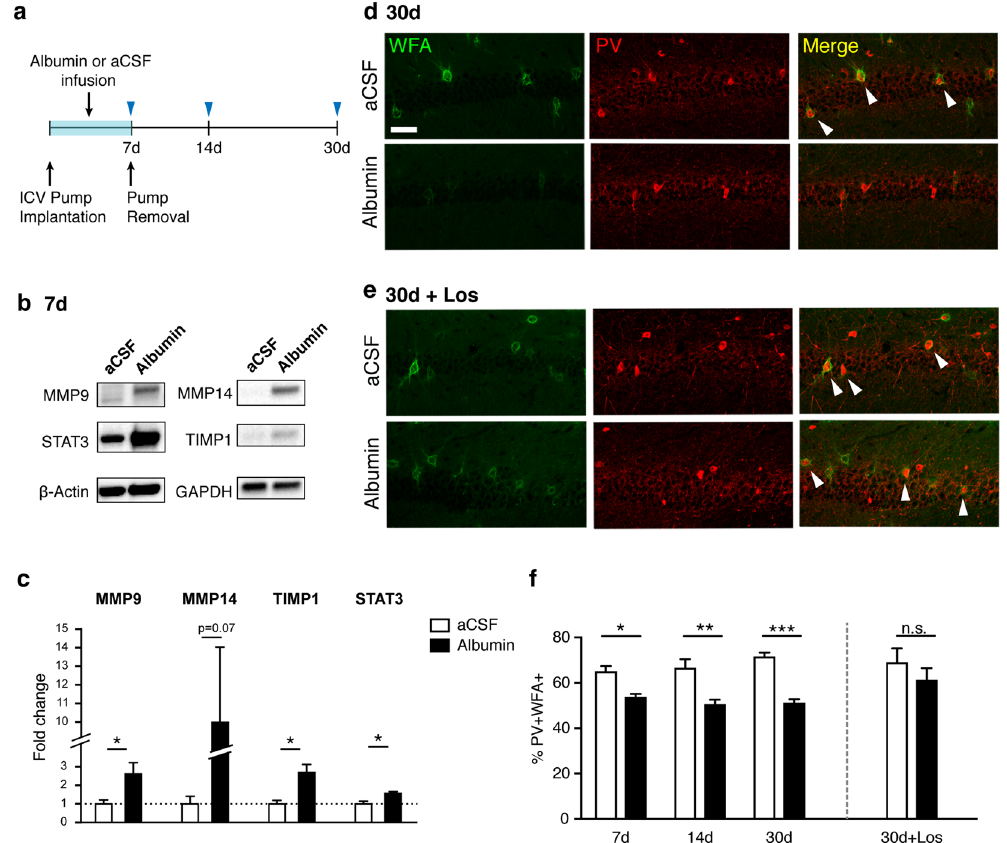
Figure 5. Albumin induced the degradation of perineuronal nets around PV( + ) interneurons and losartan attenuated the effect of albumin. ( a ) Experimental design. Intracerebroventricular ( ICV ) osmotic pumps containing albumin (0.4 mM) or aCSF were implanted in rats and mice and removed after 7 days. ( b,c ) Molecules involved in ECM remodeling including MMP9, TIMP1, and STAT3 were significantly increased in dissected rat hippocampi following albumin infusion for 7 days. Uncropped blot images are available in the Supplementary Fig. S4. Each group has four biological replicates. Unpaired student t- test. * p < 0.05, two-tailed. ( d ) Representative confocal images showing PNNs (WFA) and PV( + ) cells in the mouse hippocampal CA1 region at 30 days post implantation. ( e ) A separate set of animals was infused with albumin + losartan (10 μ M) or aCSF + losartan. Scale bar = 50 μ m. ( f ) Albumin exposure decreased the association of PNNs with PV( + ) interneurons ( * p < 0.05, ** p < 0.01, *** p < 0.001, Two-way ANOVA, post-hoc Sidak’s test, two tailed). Co- administration of losartan attenuated the effect of albumin (p > 0.05, Mann-Whitney test, two-tailed). n.s., not significant. Each condition has three or four biological replicates (n =